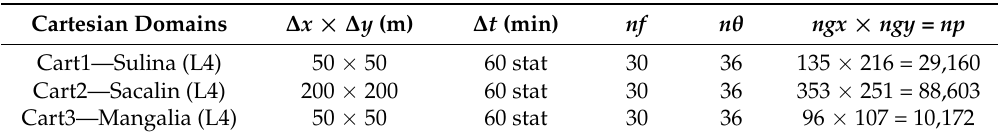
Table 2. Characteristics of the Cartesian computational domains considered for the SWAN model simulations focused on the western side of the Black